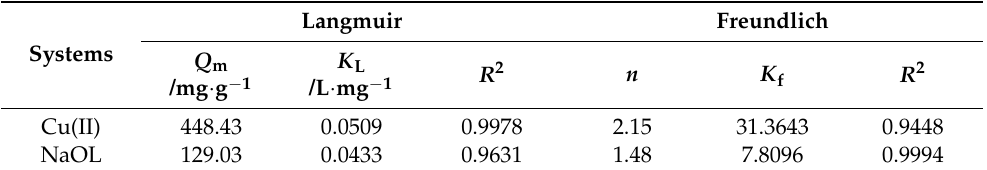
Table 4. Adsorption isotherm parameters for the adsorption of Cu(II) and NaOL on SiO 2 –g–PBMA– b–PDMAEMA. Figure 4. ( a ) Adsorption isotherms and ( b ) Linear fitting plots of Langmuir and Freundlich models